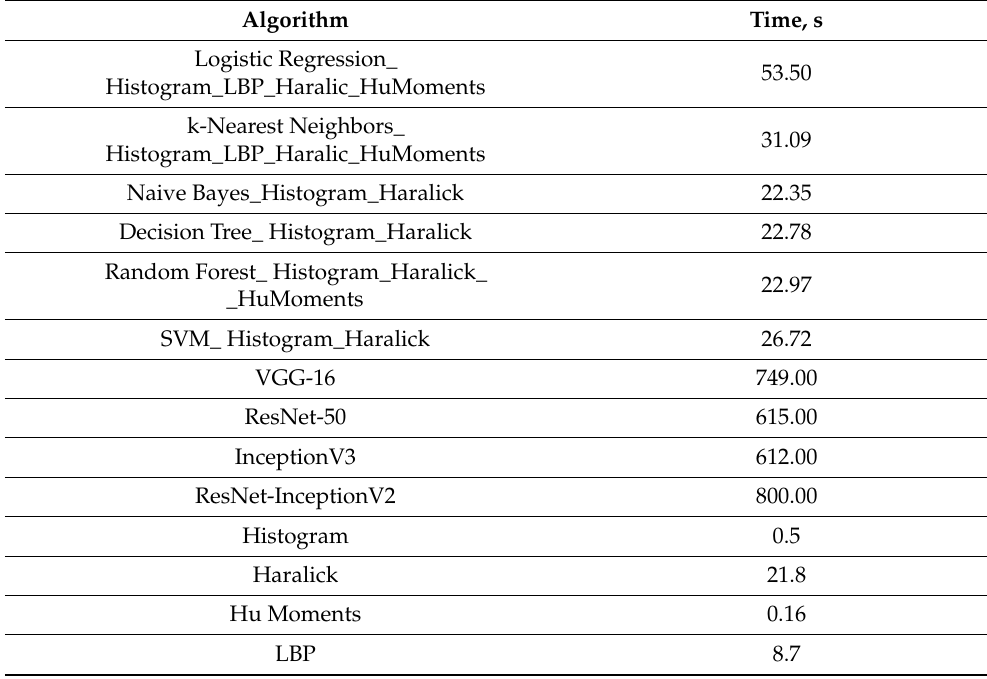
Table 2. Comparison of learning time of